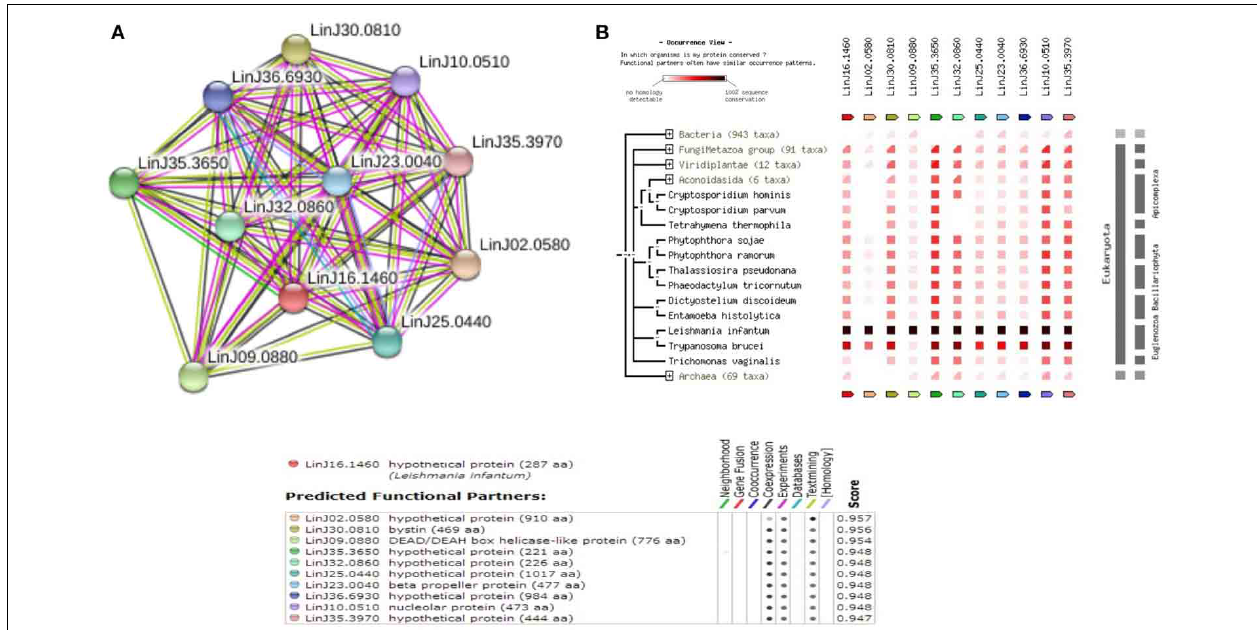
FIGURE 9 | (A) COG network of the hypothetical protein (E9BCZ9) and its interacting members. (B) Phylogenetic co-occurrence pattern of the protein (E9BCZ9) and its interacting members, seen to be conserved across Eukaryotes.